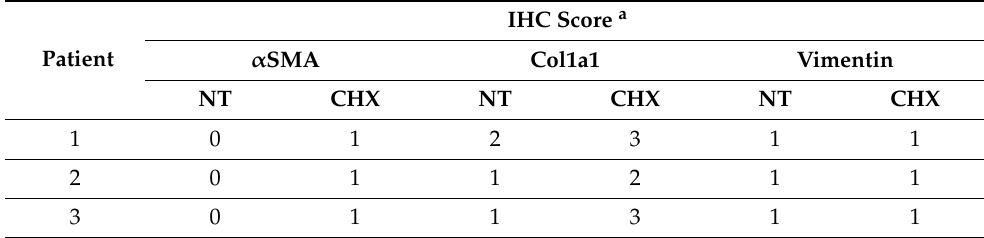
Table 1. Immunohistochemical scoring of staining intensity for α SMA, Col1a1, and vimentin.